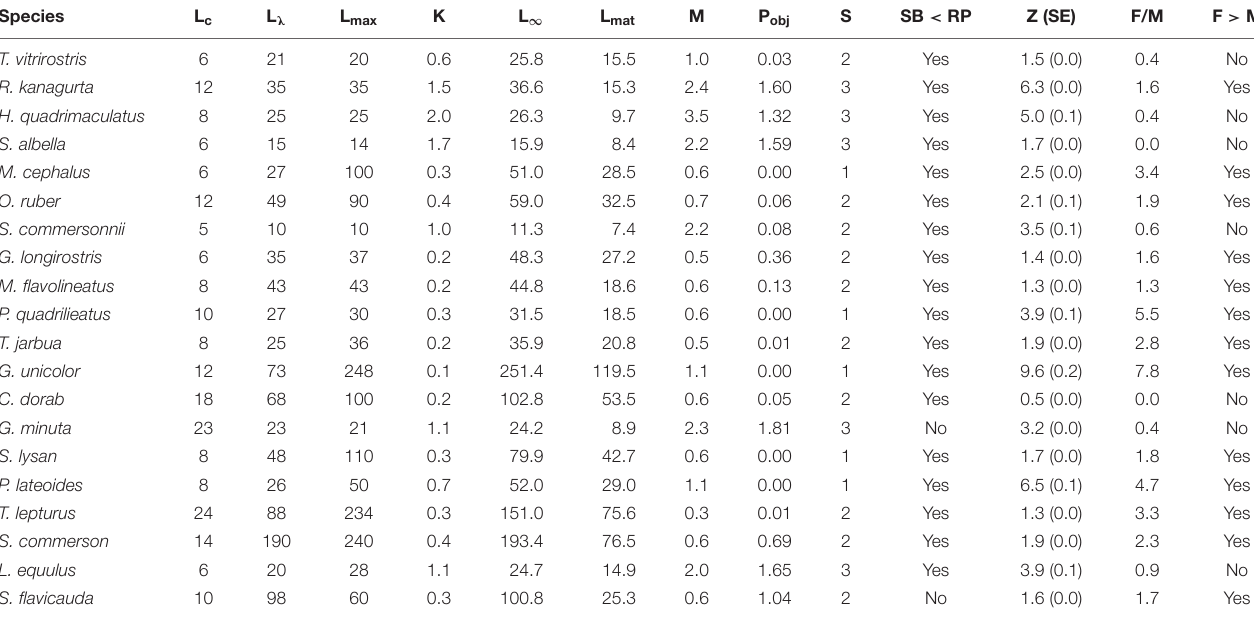
TABLE 3 | Values of the life history parameters and indicators of overfishing.